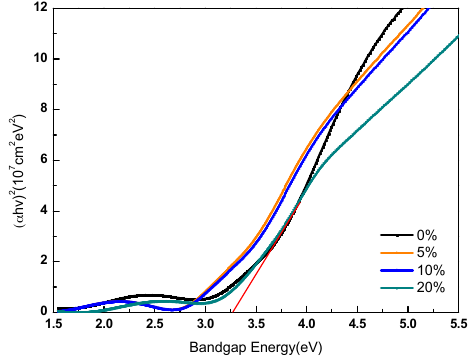
Figure 4. Absorption coefficient spectra of IGO films.